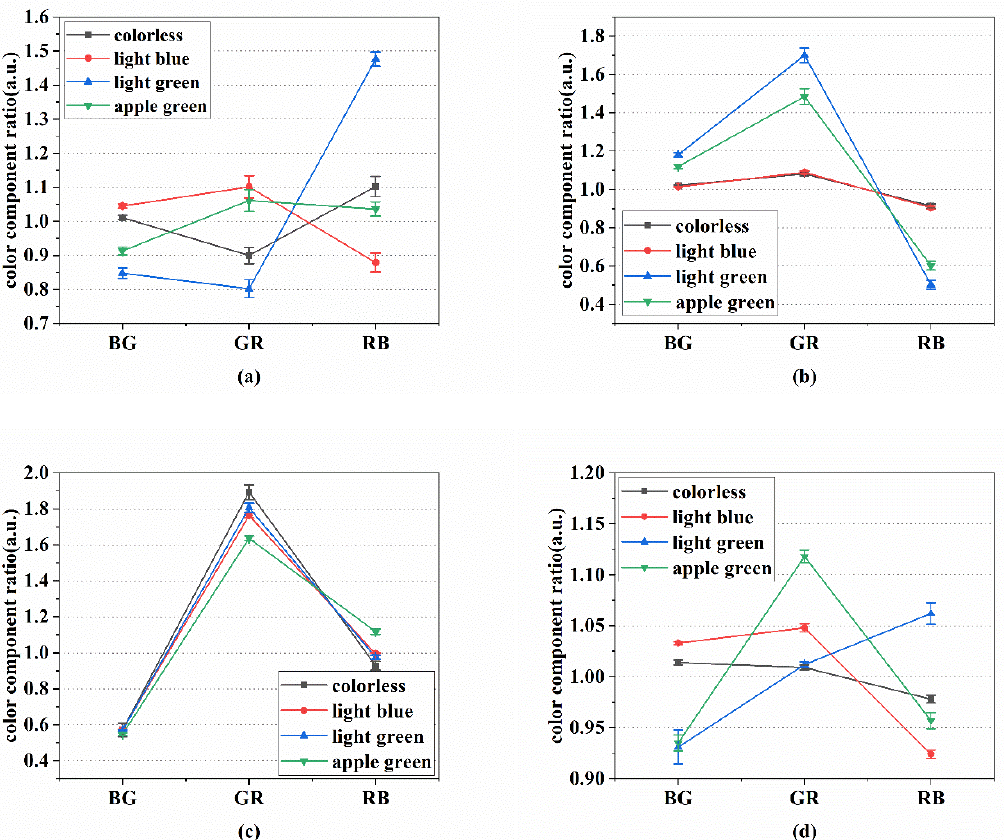
Figure 3. The mean values of the color parameters BG , GR and RB of the colorless, light blue, light